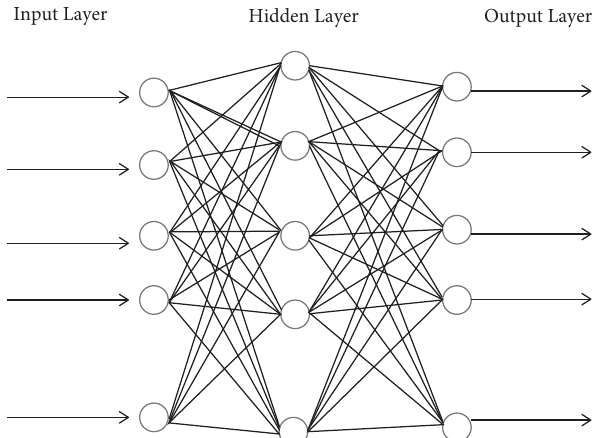
Figure 1: The architecture of the BP ANN